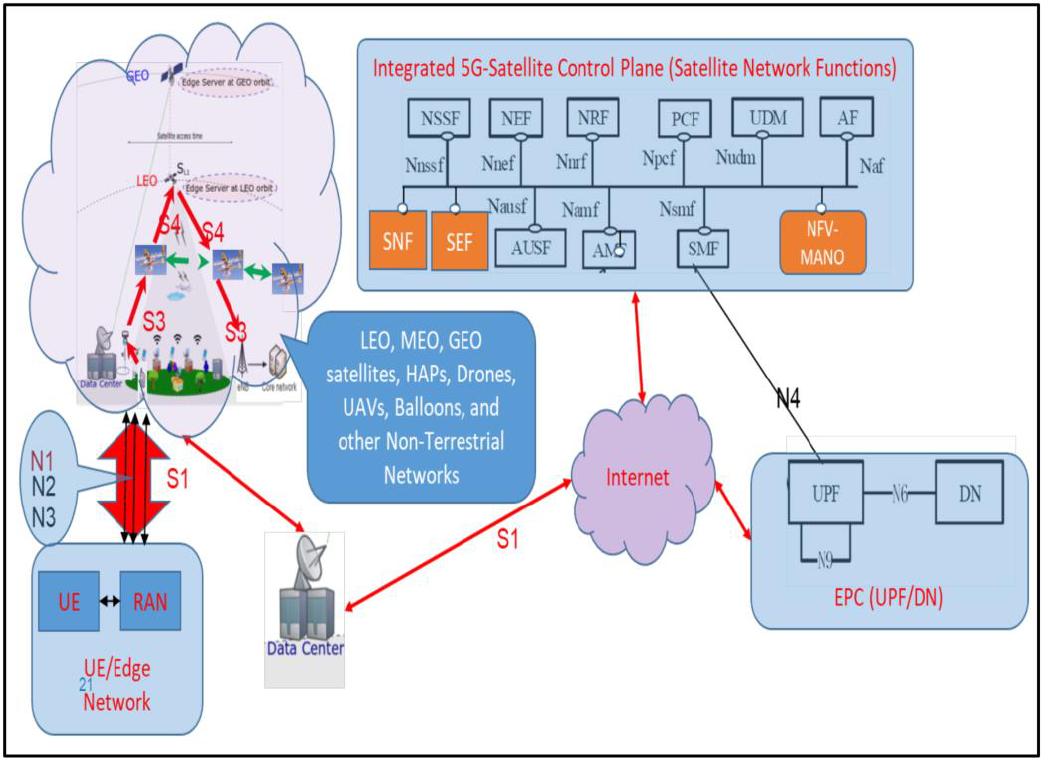
Figure 4. B5H network structure.